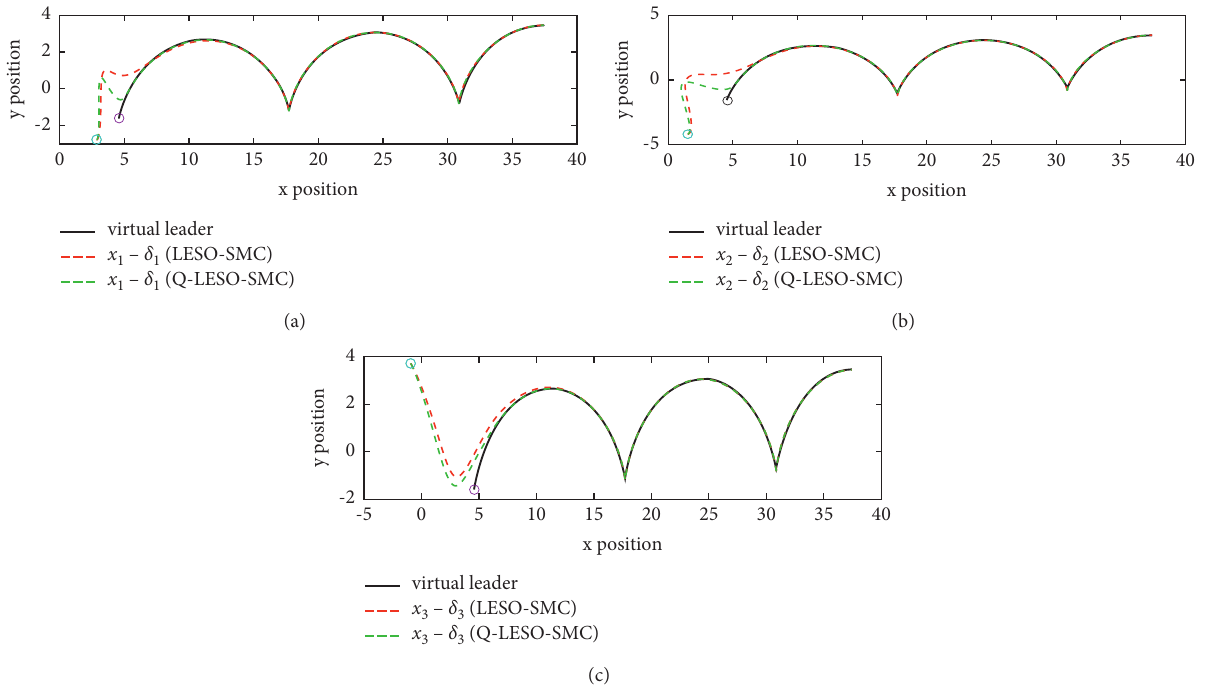
Figure 9: The tracking trajectories of the three followers and the virtual leader in Case A. (a) The tracking trajectories of the 1st follower for the virtual leader. (b) The tracking trajectories of the 2nd follower for the virtual leader. (c) The tracking trajectories of the 3rd follower for the virtual